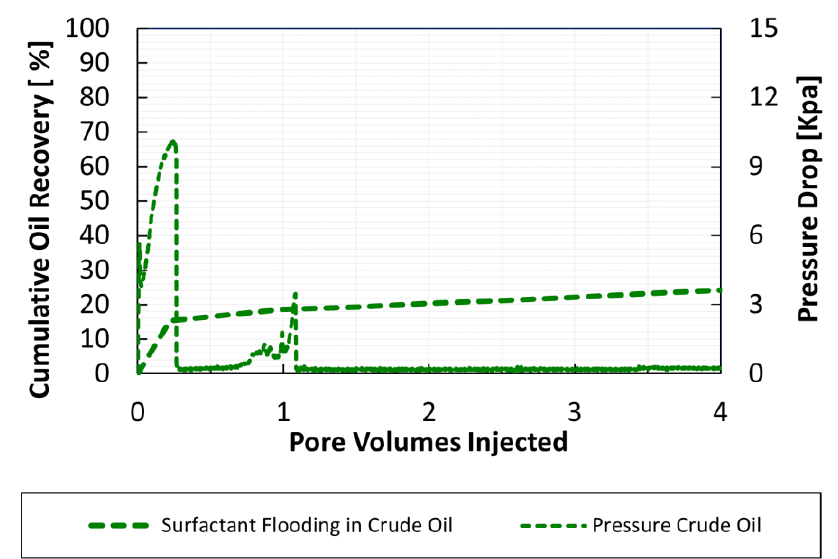
Figure 9. Oil recovery by surfactant flooding for crude oil.